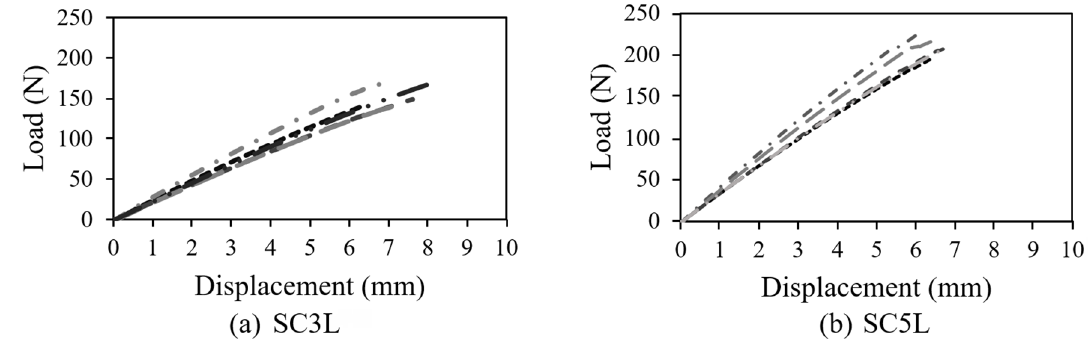
Figure 6. Load x Displacement diagram in flexural test (a) SC3L; (b) SC5L. Table 2. Mechanical properties- sandwich composite laminate – flexural test Mechanical Properties